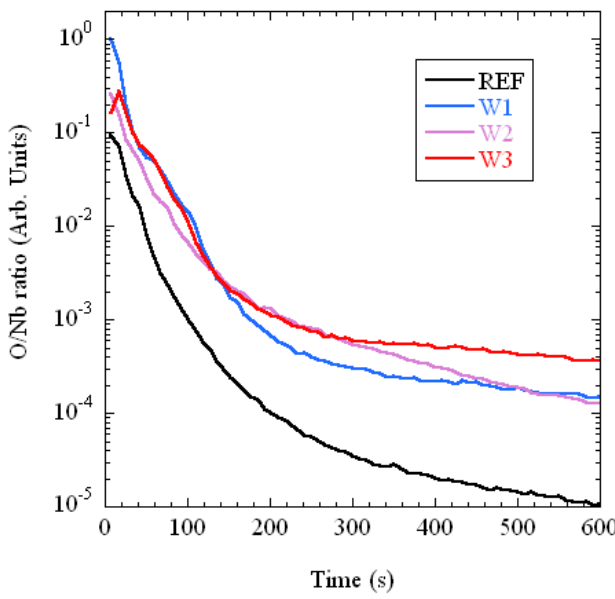
FIG. 12. (Color) SIMS oxygen depth profiling done at NCSU for samples baked at different temperatures. The sample treatments are indicated in Table